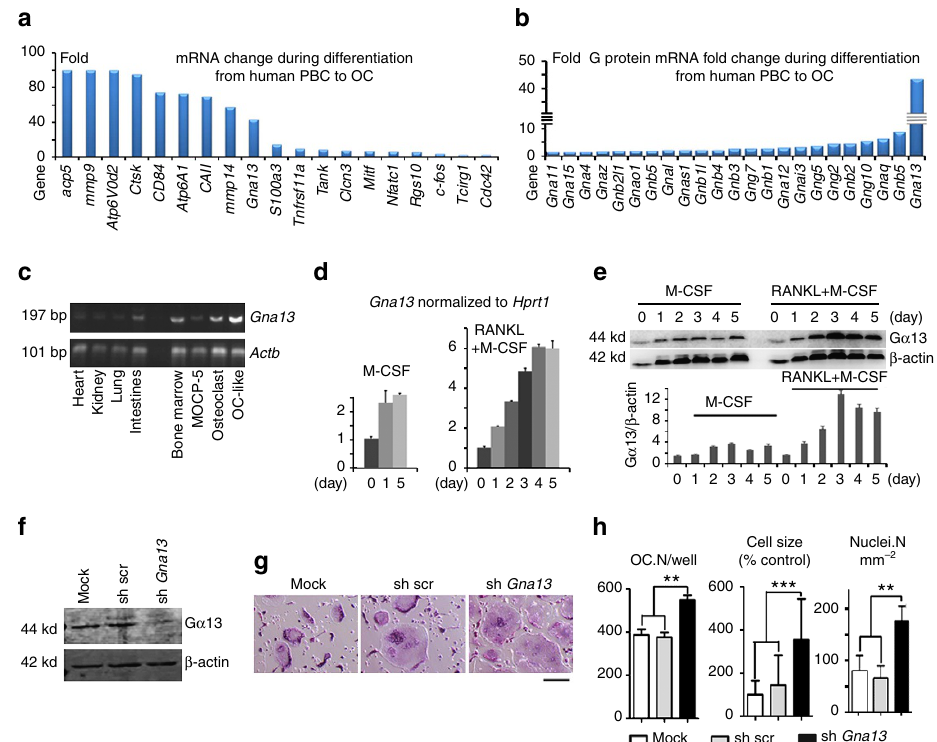
Figure 1 | G a 13 which is induced by RANKL and M-CSF inhibits osteoclastogenesis. ( a , b ) Microarray profile of gene expression during osteoclast differentiation. OC, osteoclasts; PBM, peripheral blood monocytes. ( c ) Semi-quantitative reverse transcription–PCR to detect Gna13 mRNA level in murine tissues and cells. ( d ) Quantitative reverse transcription–PCR to analyse time-course expression of Gna13 , normalized to Hprt1 , in murine bone marrow monocytes (BMMs) under the treatment of M-CSF, or M-CSF and RANKL; N Z 4. ( e ) Western blot to analyse time-course expression of G a 13 in BMMs under the treatment of M-CSF or M-CSF and RANKL, and its quantification in lower panel; N Z 4. ( f ) Western blot to analyse G a 13 expression in non- infected BMMs (mock) and BMMs infected with lentivirus expressing scrambled short hairpin RNA (shRNA) (sh-src) or shRNA targeting Gna13 (sh- Gna13 ). ( g ) TRAP staining to detect osteoclast formation of mock, sh-src and sh- Gna13 BMMs. ( h ) Quantification of cell number (OC.N/well and nuclei.N mm (cid:2) 2 ; N Z 10) and relative cell size ( N Z 100) in g . OC.N/well, osteoclast (TRAP positive multinucleated cell) number per well. Nuclei.N mm (cid:2) 2 , osteoclast nuclei number per mm 2 . Results in d , e , h are expressed as mean ± s.d.; ** P r 0.01; *** P r 0.001 (Student’s t -test). Scale bars, 200 m